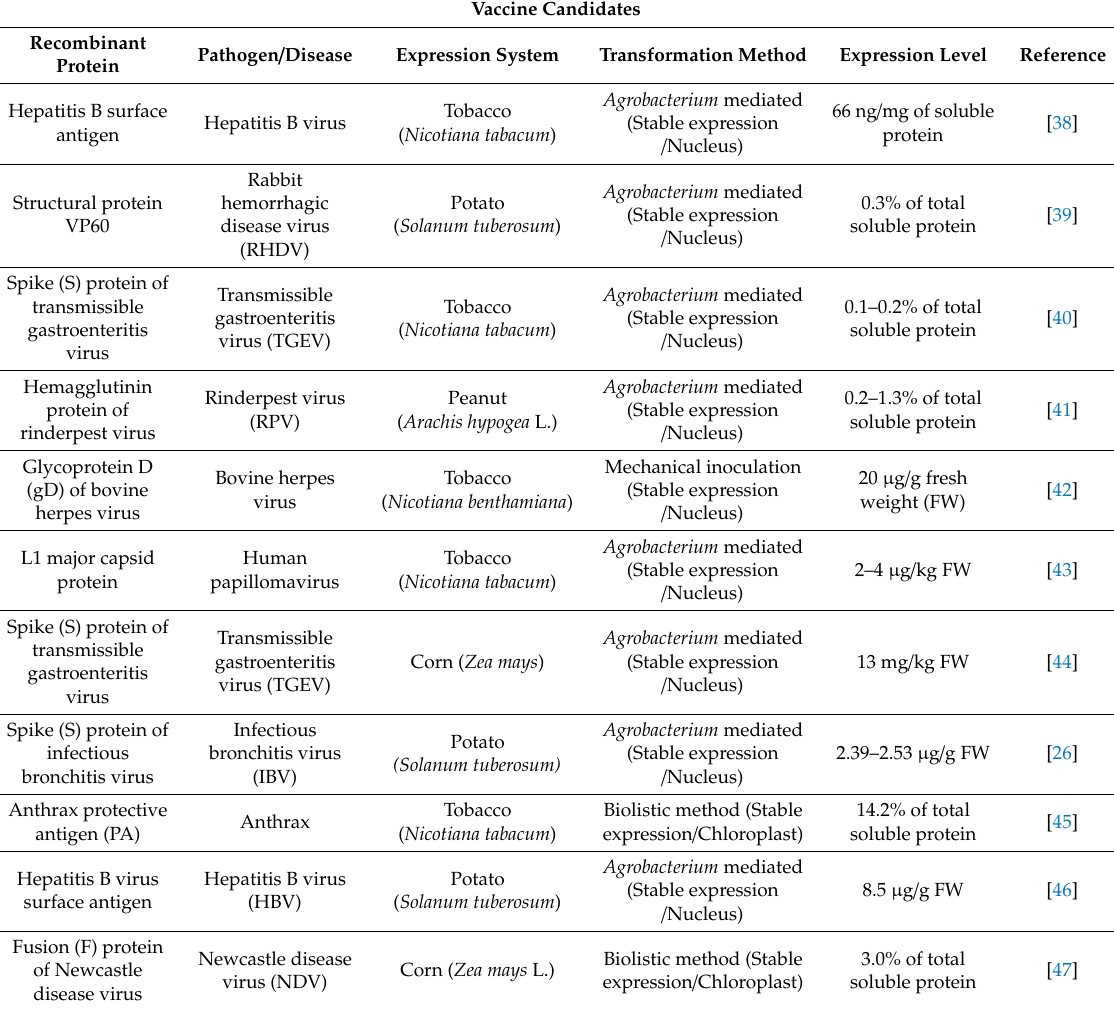
Table 2. Selected list of vaccine candidates and antibodies expressed in plants against various